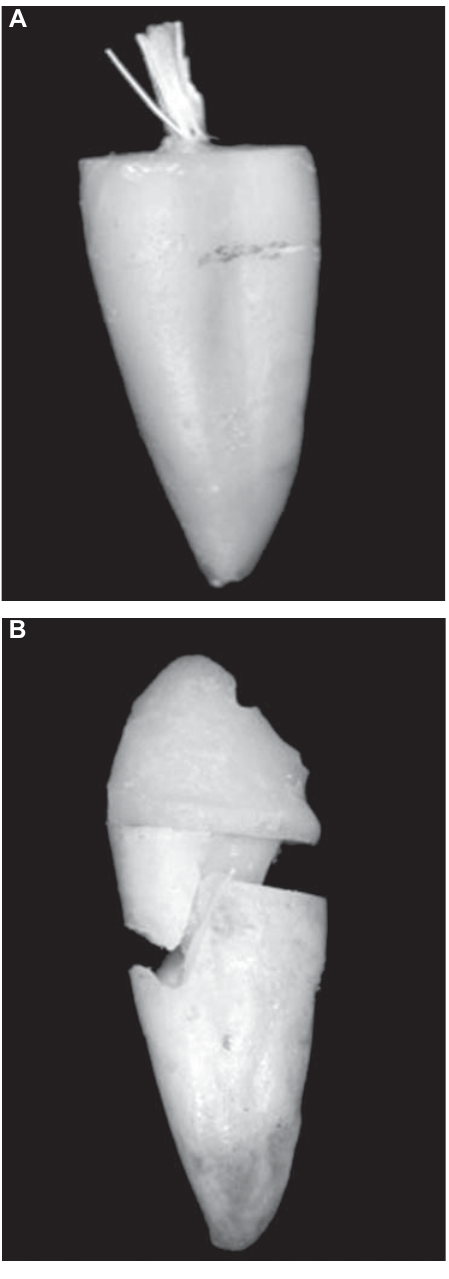
Figure 5- Predominant failure patterns in group 1 (A), group 2 (B), group 3 (C) and group 4